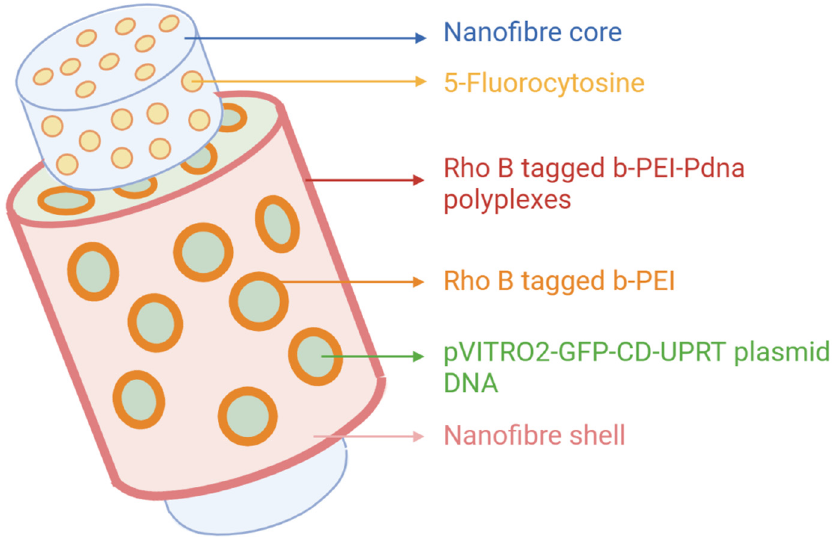
Figure 6. Schematic diagram of core–sheath nanofibre transporting 5-FC and the suicide gene. Created with BioRender.com and adapted from [77].